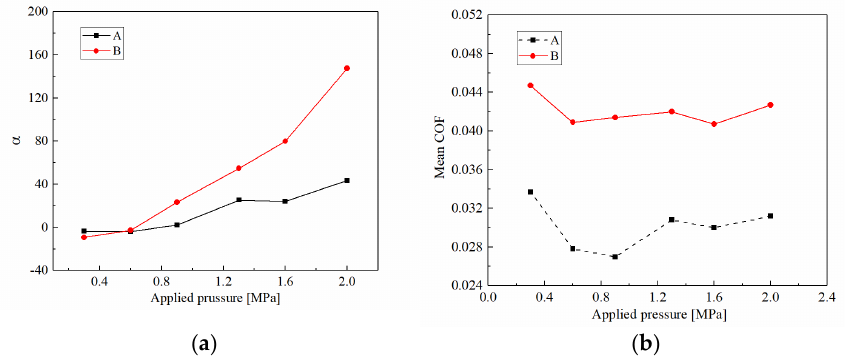
Figure 5. Variable coefficients in stable working stage ( a ) and mean COFs ( b ) of CBFM-A and CBFM-B under different applied pressures.